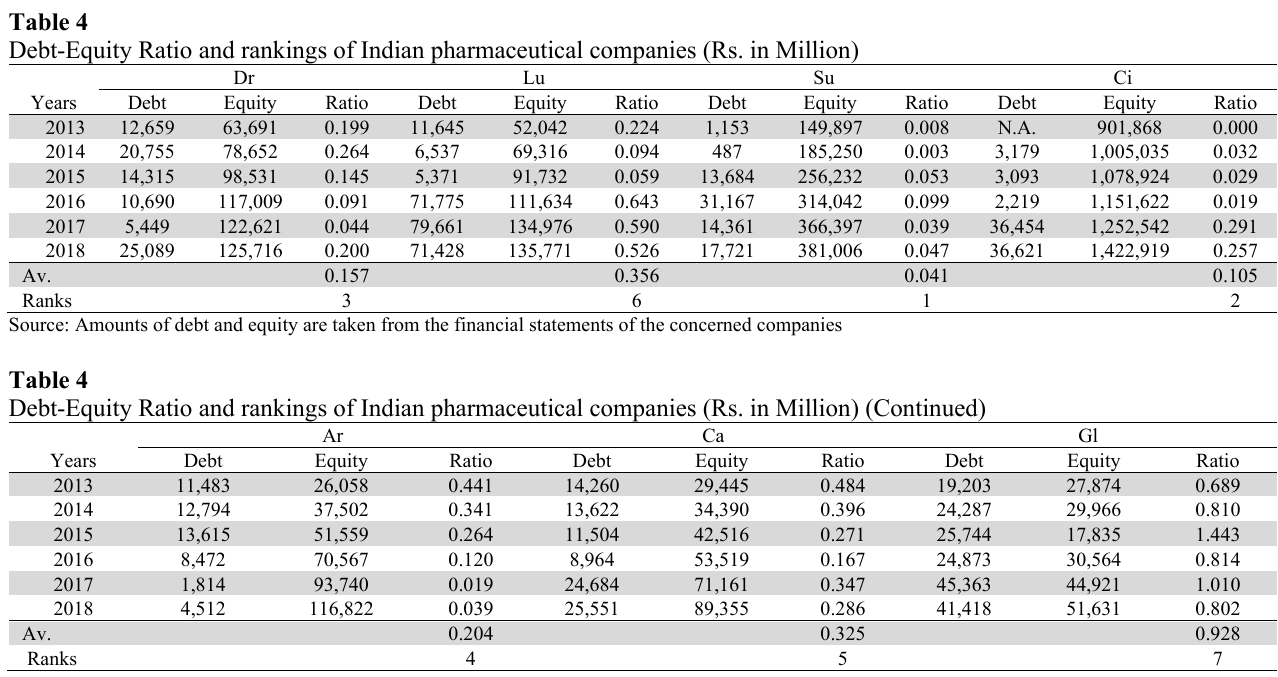
Table 4 explains that the owners’ equity point of view the solvency of the Su, Ci, Dr, and Ar is satisfactory while Gl, Ca, and Lu are weaker, relatively. The relative correlation of the debt-equity and firm size determinants (sales, TA, and WC) ranks will explain the relationship of debt-equity ratio with each size determinants, individually. Qualitative relationship between Total assets and Debt- Equity relationship of Indian Pharmaceutical firms Indian pharmaceutical companies Ranks Su